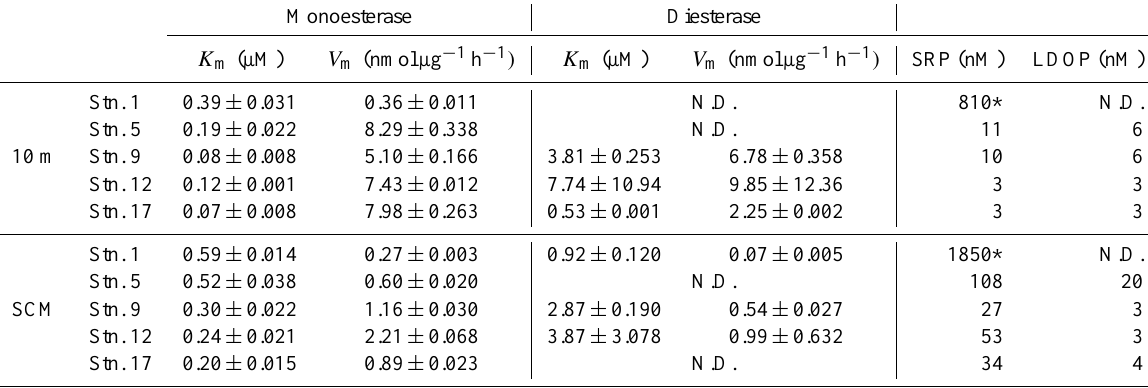
Table 2. Half-saturation constant K m and maximum hydrolysis rate V m of phosphate monoesterase and diesterase calculated from the results of kinetic assay experiments. Note that V m is normalized to chlorophyll a concentration. N.D. for kinetic parameters means that no value was obtained because of unsuccessful fitting; N.D. for LDOP means no data were obtained. The values with asterisks were obtained by the conventional colorimetric method.